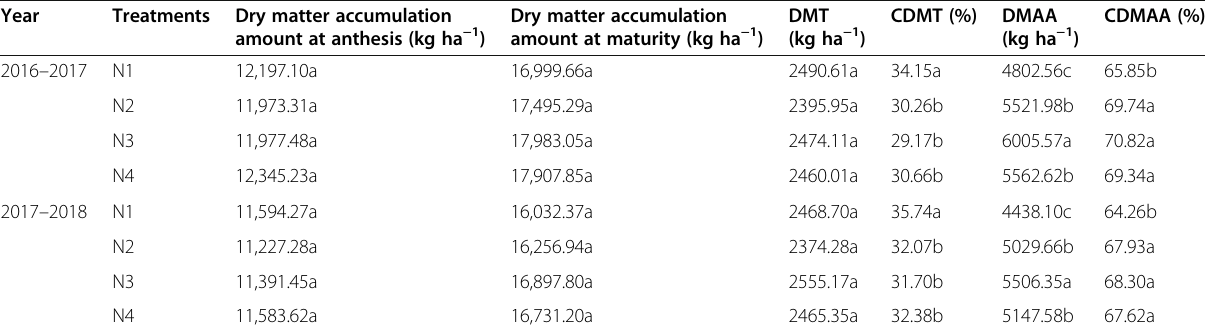
Table 1 Effects of four split nitrogen fertilizer treatments on dry matter accumulation amount at anthesis and maturity and dry matter translocation after anthesis. Different letters in each column represent significant differences in each tissue among four treatments at each sampling date according to LSD at 5%